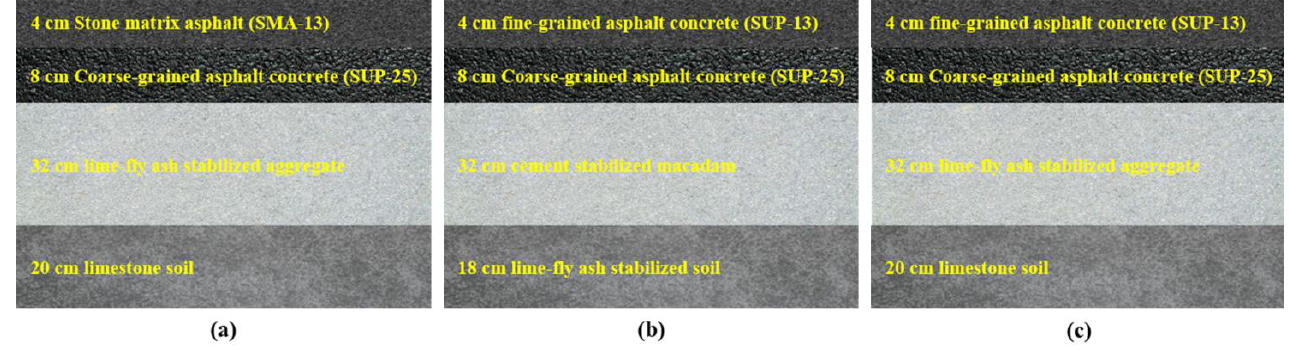
Figure 1. Original structure of the test roads: ( a ) test road 1; ( b ) test road 2; ( c ) test road